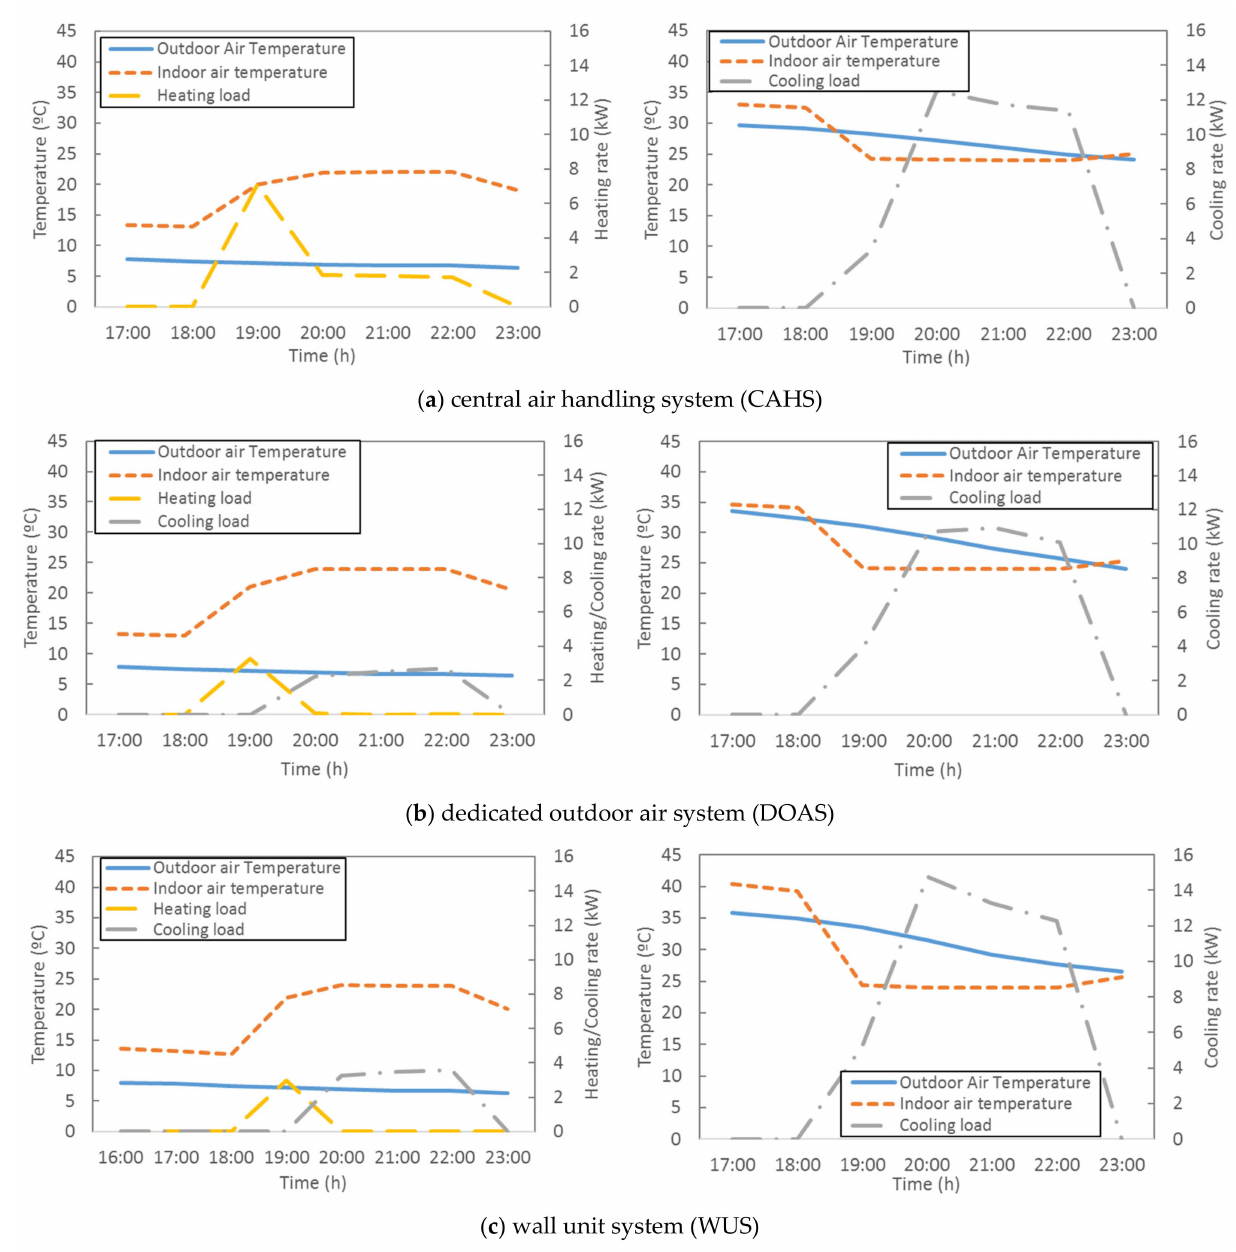
Figure 4. Simulated thermal load (heating and cooling loads) and temperature profile of summer and winter design days for each HVAC type: ( a ) CAHS, ( b ) DOAS, and ( c ) WUS. Figure 5a shows the normalized and integrated exposure ( NIE and IE ) of the bar/pub with a simulated volume of 150 m 3 for each type of HVAC system (Figure 2) based on the base-case conditions listed in Table 2. The exposure to aerosols of the room occupants, evaluated using IE and NIE , was estimated for 3 h/day of continuous exposure to a continuous bioaerosols source for the same duration. The NIE values reported in Figure 5a were obtained by normalizing the IE associated with each HVAC system type by using the lowest IE (which was for the